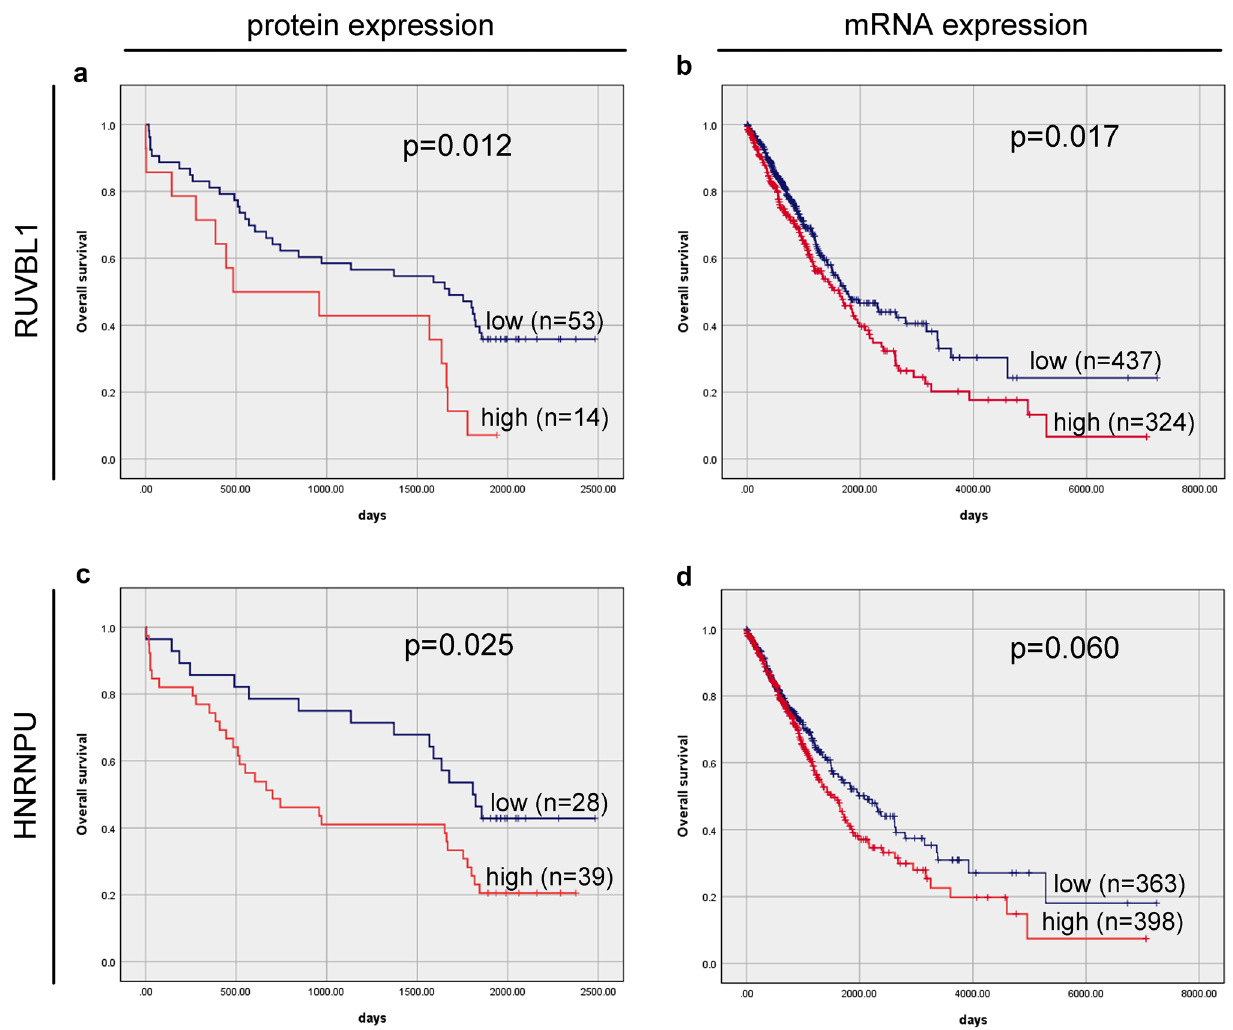
Fig. 3 Kaplan–Meier survival curves and log-rank test for overall survival of NSCLC patients based on a RUVBL1 protein expression and b RUVBL1 mRNA expression, c HNRNPU protein expression and d HNRNPU mRNA expression. n – number of patients in the group